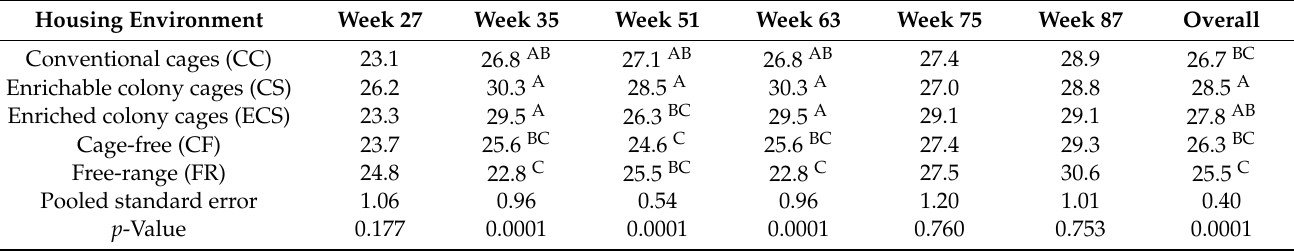
Table 3. The effect of housing environment on shell color of brown egg layers by week and overall 1